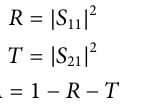
Frontiers in Materials |